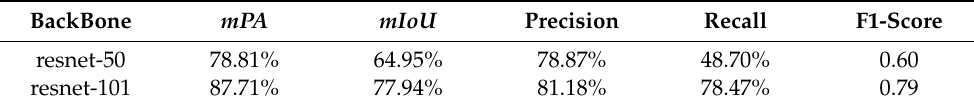
Figure 10. New landslide detection and segmentation results using Mask R-CNN based on the dif- ferent backbones. ( a1 – a4 ) represent different landslides: ( a1 ) is a single intact landslide with vege- tation cover; ( a2 ) is a broken-shaped landslide with vegetation cover; ( a3 ) is close to the surrounding ground features; ( a4 ) is multiple landslides in an image. ( b1 – b4 ) are the results using resnet-50 as the detection backbone. ( c1 – c4 ) are the results using resnet-101 as the detection backbone. Table 1. New landslide detection results using Mask R-CNN with different backbones.